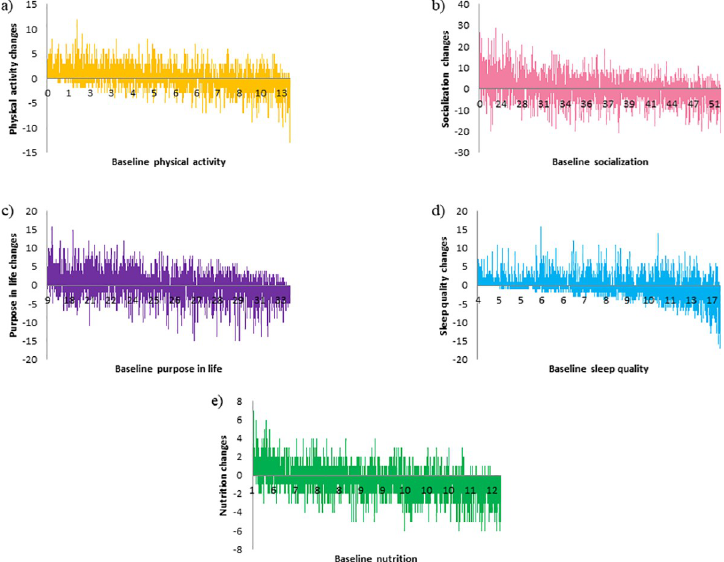
Fig 7. In the x axis of the waterfall plot baseline scores are reported and in the y axis changes between baseline and the follow-up are reported in the different domains: a) physical activity, b) socialization, c) purpose in life, d) sleep and e) nutrition.